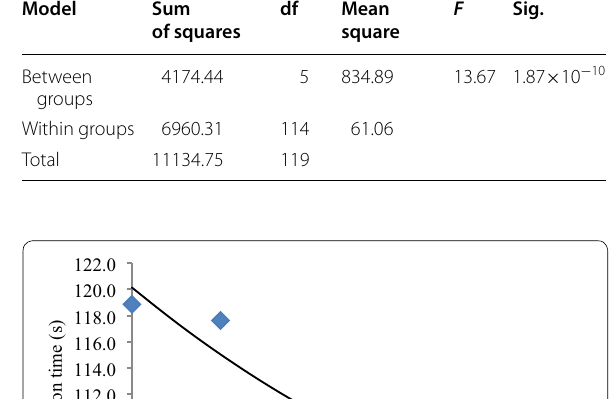
1.63 x 0.009 x 2 − + = 30.76 is sig- = 0.95 indicates =